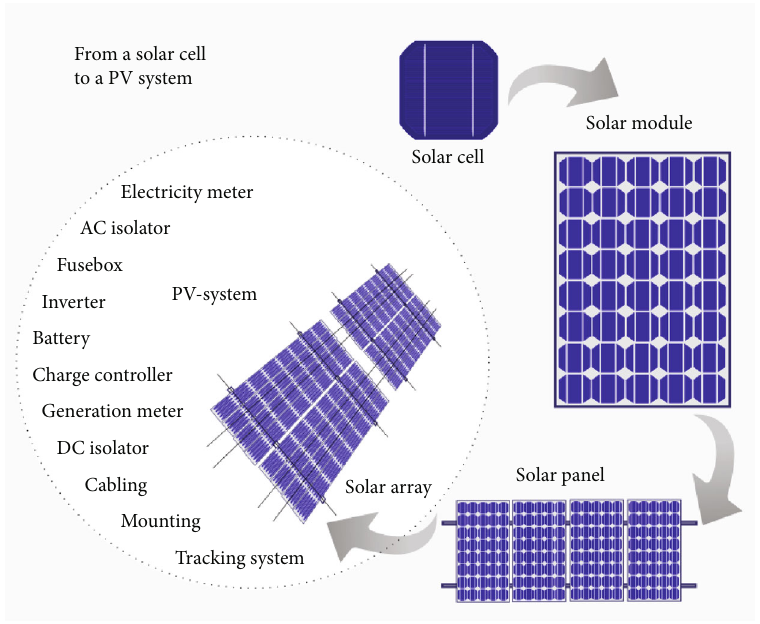
Figure 4: PV system model